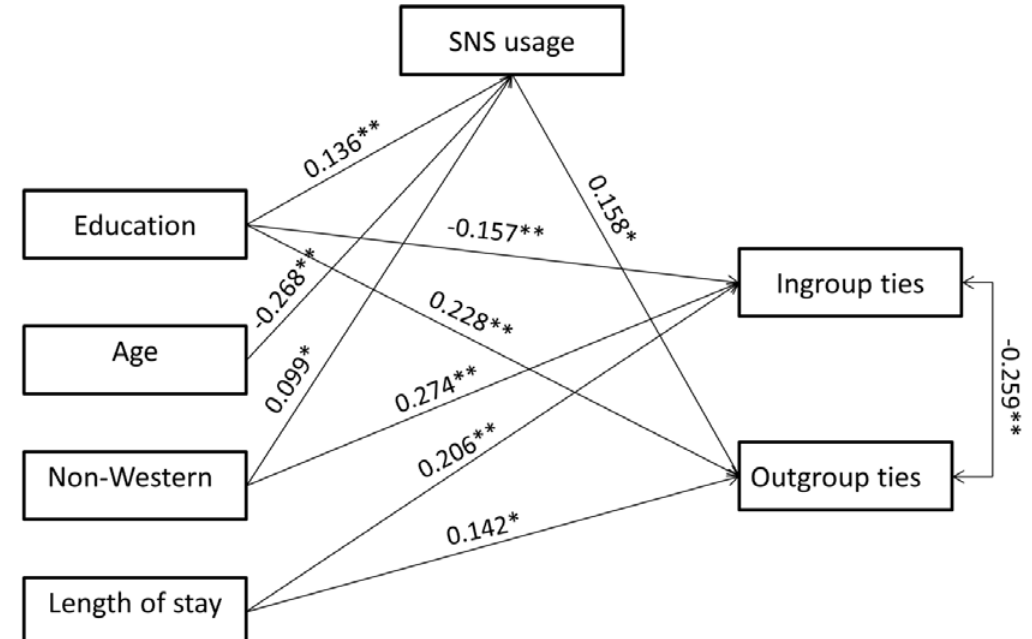
Figure 1. SEM results of frequency of SNS usage on in- and out-group